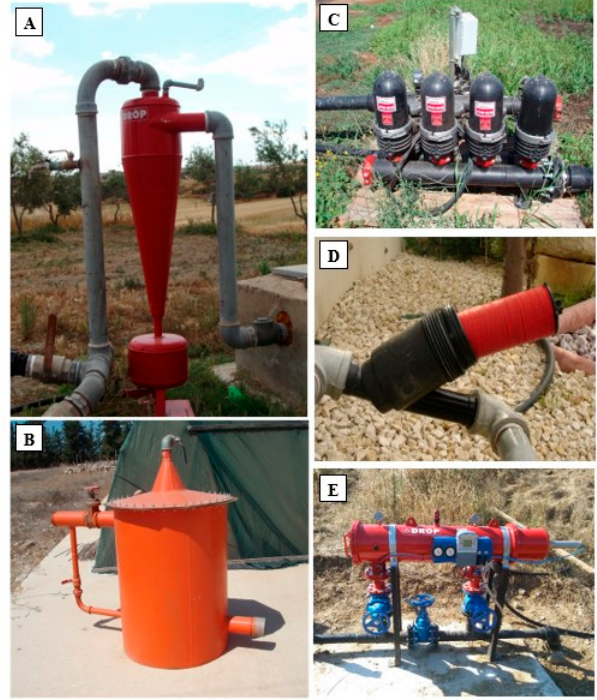
Figure 3. Different types of filters; a hydrocyclone device used for water and sand separation ( A ); a sand–gravel filter used for algae and organic matter removal, usually from an open water reservoir ( B ); a series of an automatic disc filter system ( C ); a manual disc filter ( D ); an automatic self-cleaning filter with a self-cleaning backwash mechanism ( E ).